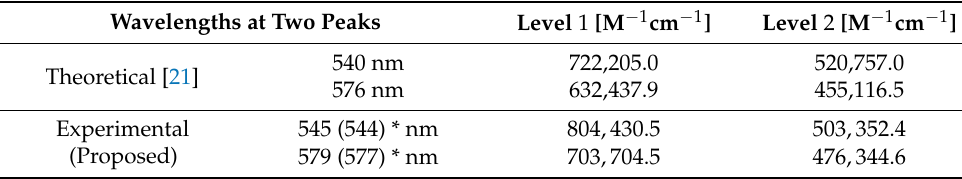
Table 1. Comparison of the molar absorption coefficients of HbA1c at two peak wavelengths for the theoretically and experimentally obtained results.